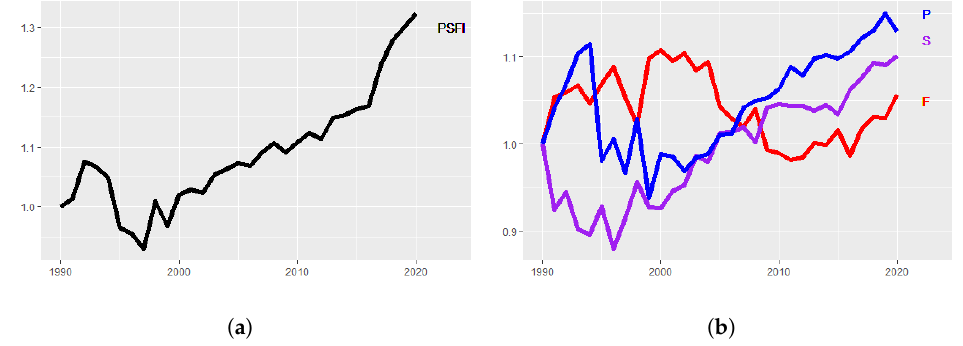
Figure 1. PSFI and its parameters for the Brazilian LDV market, 1990 to 2020, adapted from [30]. ( a ) An and DeCicco’s PSFI for Brazil, 1990 to 2020. ( b ) P, S, and F for Brazil, 1990 to